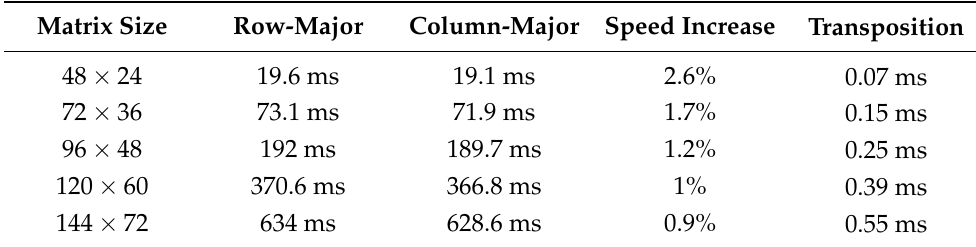
Table 2. Timing differences for one-sided Jacobi rotation with respect to data arrangement in